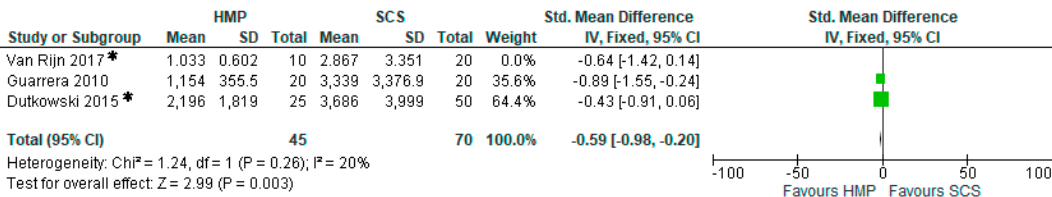
Figure 18. One week post transplantation peak serum total bilirubin in studies comparing NMP to SCS. In papers marked with “ * ”, mean and standard deviation were calculated using the method described by Wan 2014 [5].